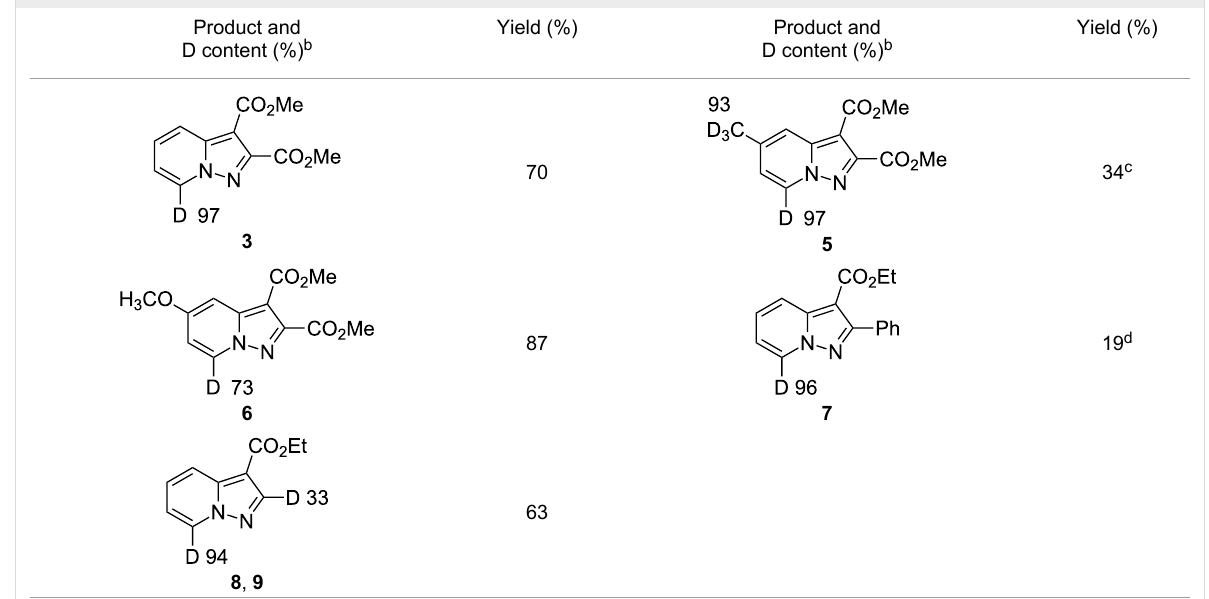
Table 1: Synthesis of deuteropyrazolo[1,5- a ]pyridine derivatives a .